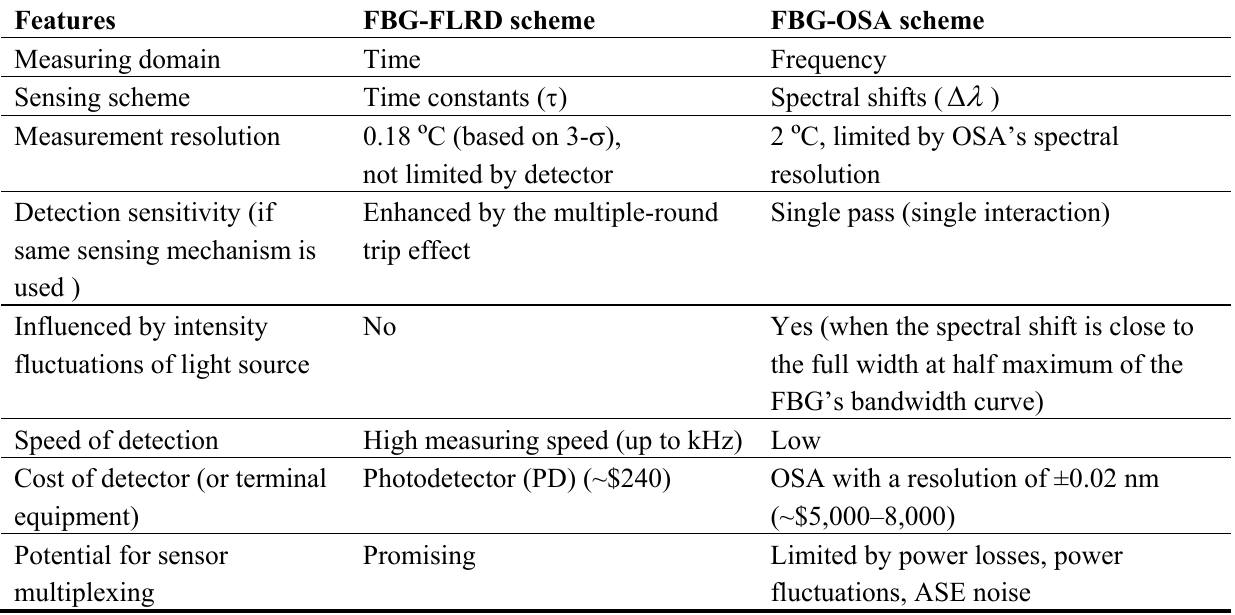
Table 2. A comparison of the FBG-FLRD scheme with the FBG-OSA scheme (Both use a SMF bare FBG as the sensing element and the thermal sensitivity is ~0.01 nm/ºC)